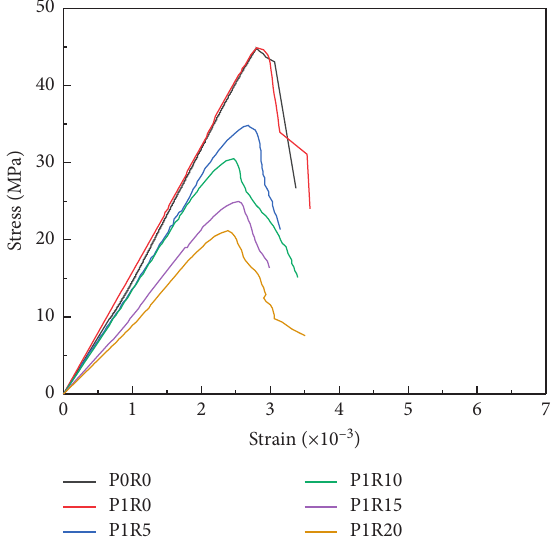
Figure 5: Axial compressive stress-strain curve.